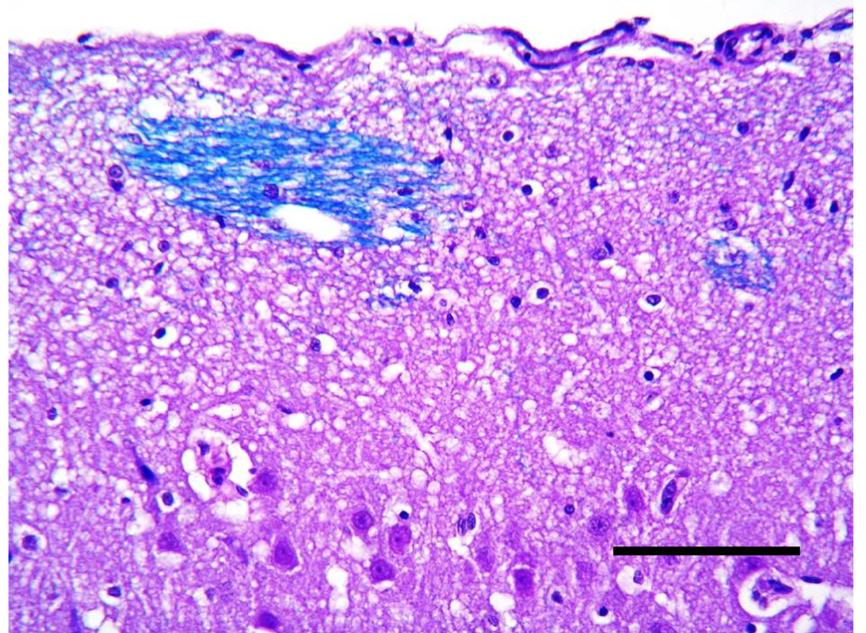
Figure 8. Cerebral cortex of the cat. Thin white matter tracts intermingled with the most superficial cerebral cortex (LFB, bar = 150 μ m).